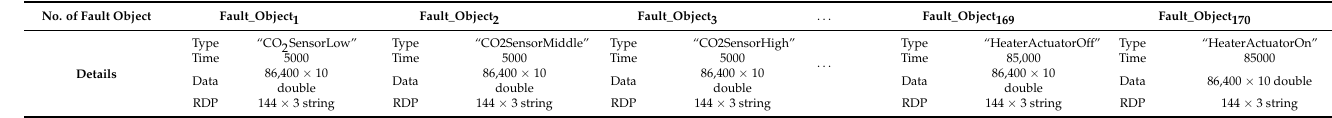
Table 21. Implemented offline library of 170 fault cases in the DCV and heating